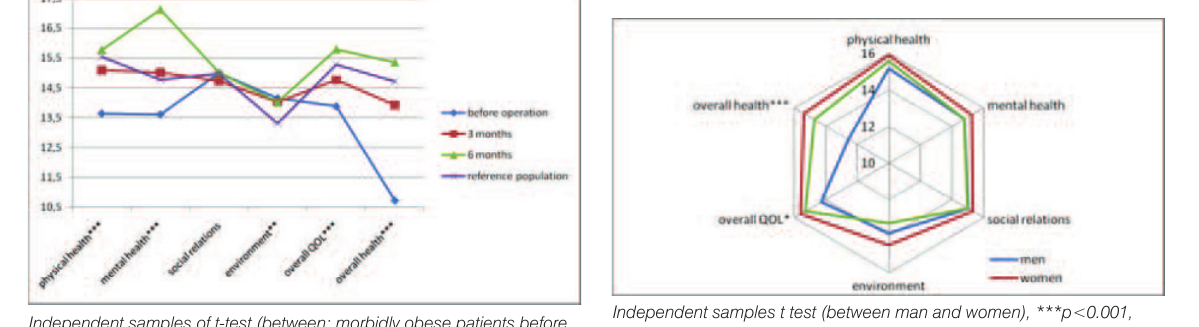
Figure 4. Comparison of WHOQOL-BREF score in morbidly obese patients 6 months following the operation according to